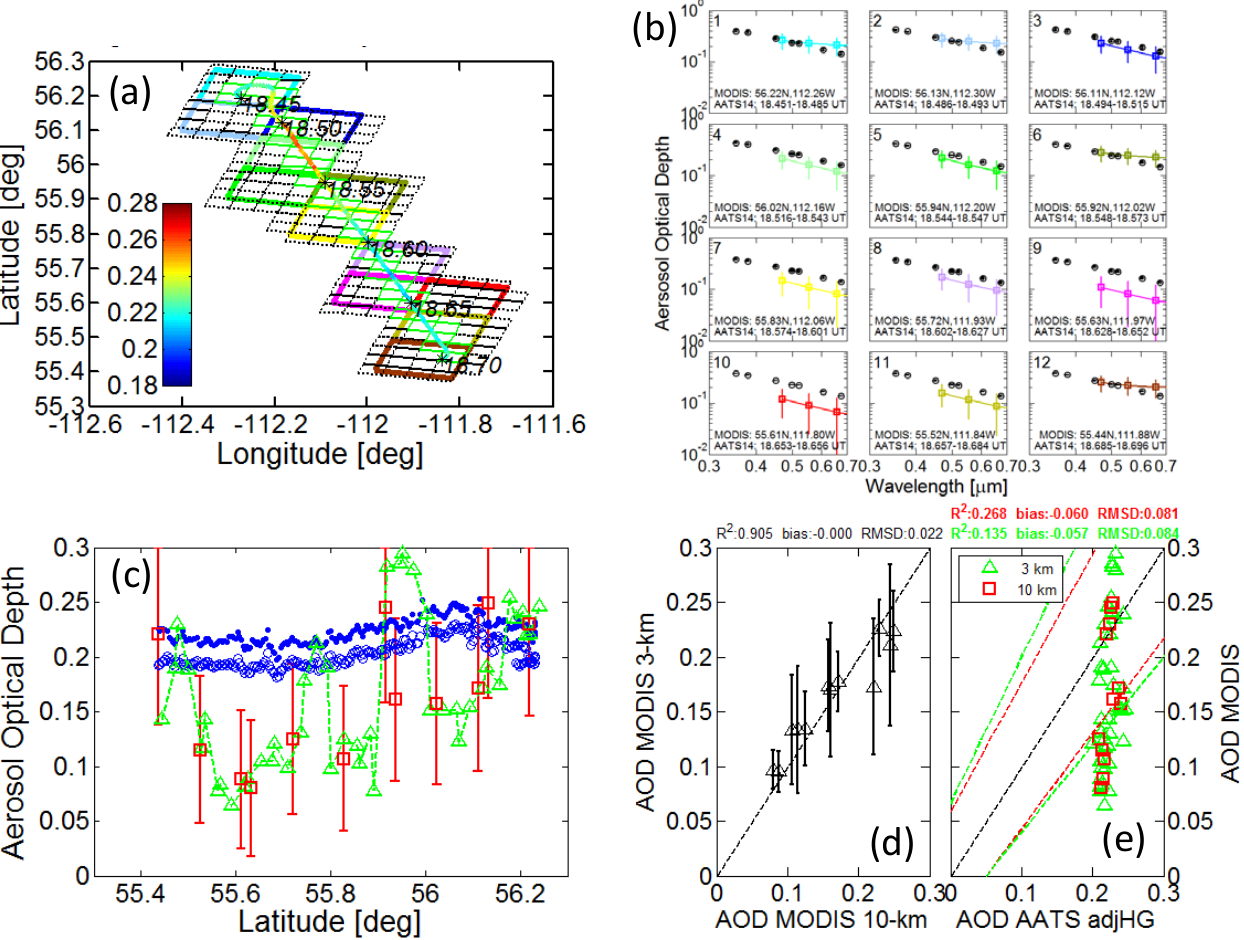
Fig. 9. Multipanel figure for 03 July Terra MODIS–AATS AOD comparison. Figure is analogous to Fig. 3 except MODIS 10km grid cells in (a) have been color-coded to match the MODIS AOD spectra shown in (b) , and MODIS spectra are shown only for the operational MODIS Figure 9. Multiframe figure for 03 July Terra MODIS/AATS AOD comparison. Figure is analogous to Fig. 3, except MODIS 10-km grid cells in 9(a) have been color-coded to match the MODIS AOD spectra shown in (b), and MODIS spectra are shown only for the operational MODIS retrieval.